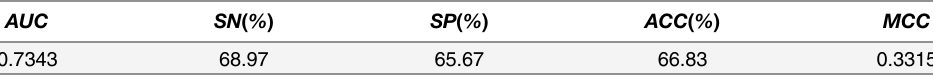
Table 4. The 10-fold cross-validation results of independent test by SVM algorithm with g = 0.005 and cutoff = 0.5.